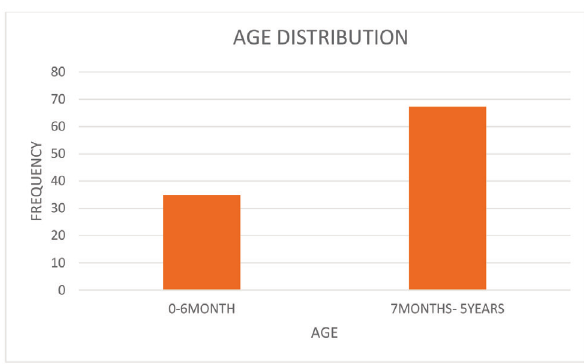
Figure 2 The age distribution of dogs presented to the